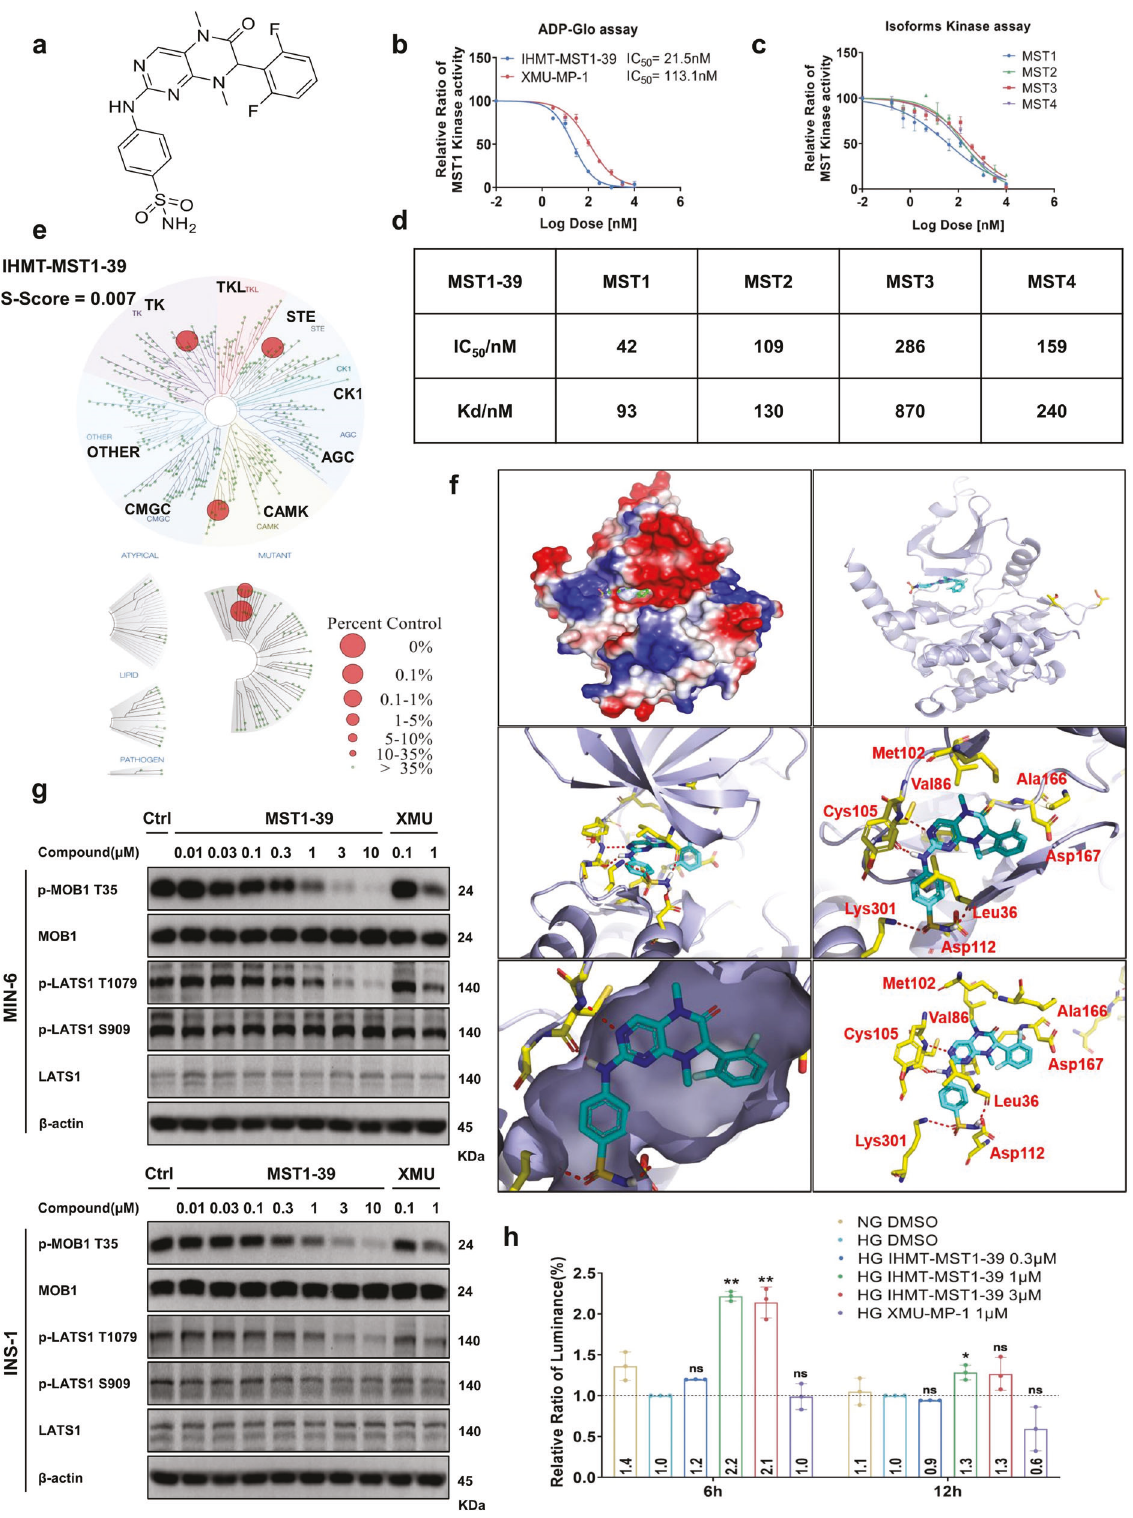
Fig. 1 Discovery of IHMT-MST1-39 as a potent and selective MST1 inhibitor. a The chemical structure of IHMT-MST1-39. b ADP biochemical assay determination of IC 50 of IHMT-MST1-39 and XMU-MP-1 against MST1 at different compound concentrations. c , d IC 50 and KD values of IHMT-MST1-39 against different MST isoforms. Data were expressed ± SEM from three independent experiments ( n = 3). e The KINOME-scan result of IHMT-MST1-39 against a panel of 468 kinases. f Molecular modeling analyses of the binding mode of MST1 with IHMT-MST1-39. MST1 homology model, template PDB code:6yat. g Inhibitory effects against the phosphorylation of MOB1, LATS1 in rodent pancreas cell lines after treatment of compound for 2 h. h YAP-TEAD reporter activity was measured in MDA-MB-231 cells exposed to high glucose, and then treated with compound at different time, compound activities were compared to high glucose